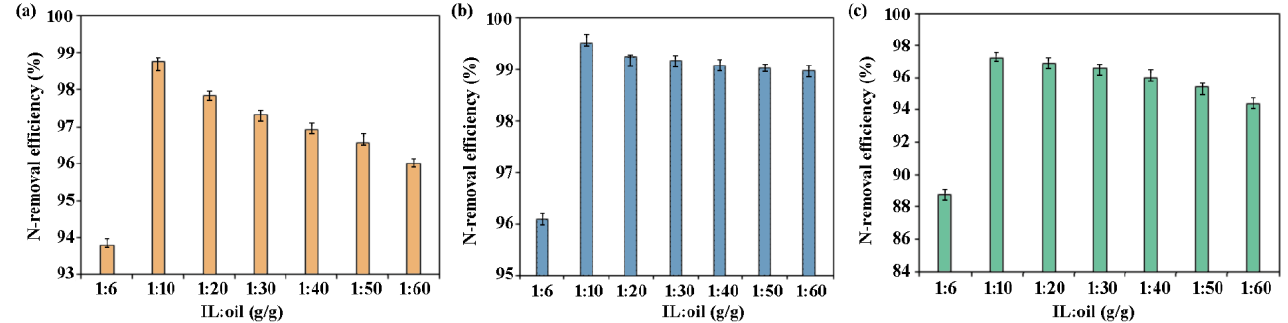
Separations 2021 , 8 , x FOR PEER REVIEW 11 of 17